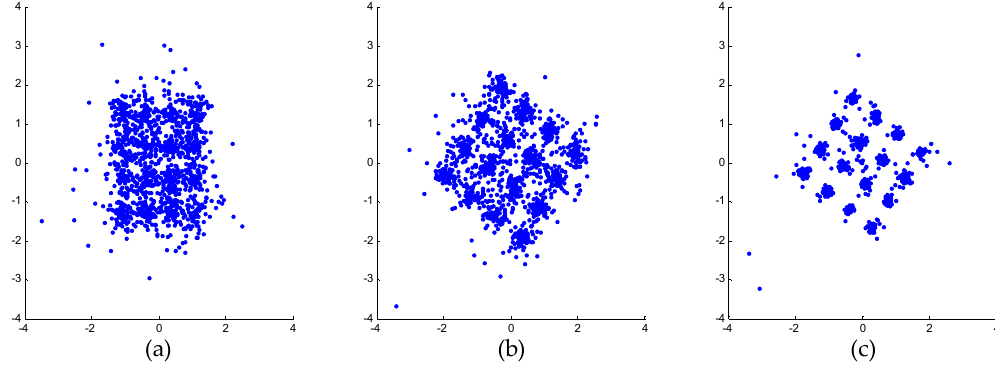
Figure 11. Demodulated constellations of the weak 16-QAM signals: ( a ) unmitigated signal; ( b ) output of AIC; ( c ) output of the proposed algorithm.